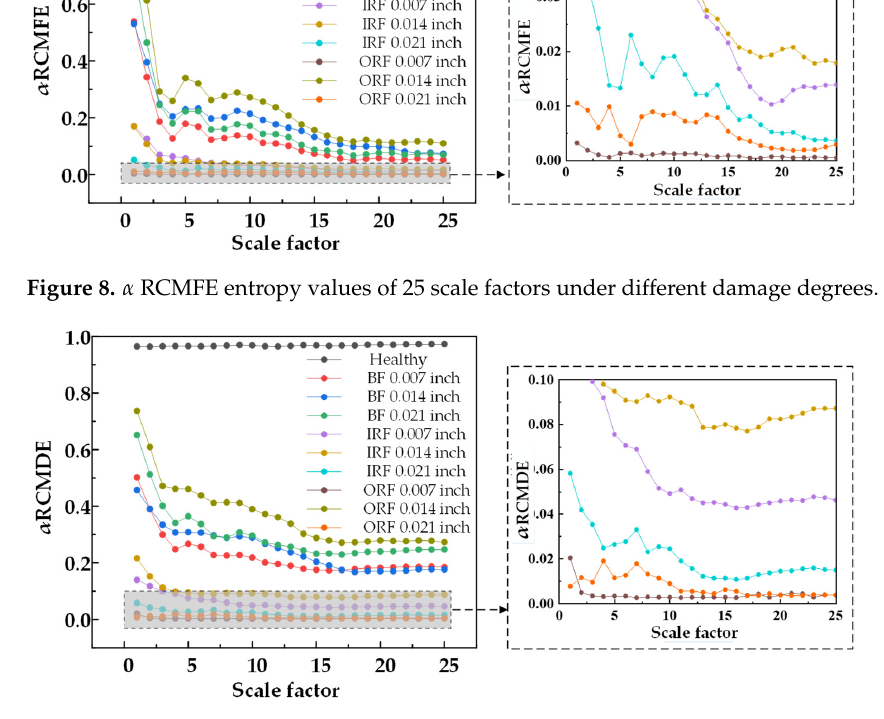
Figure 9. α RCMDE entropy values of 25 scale factors under different damage degrees.